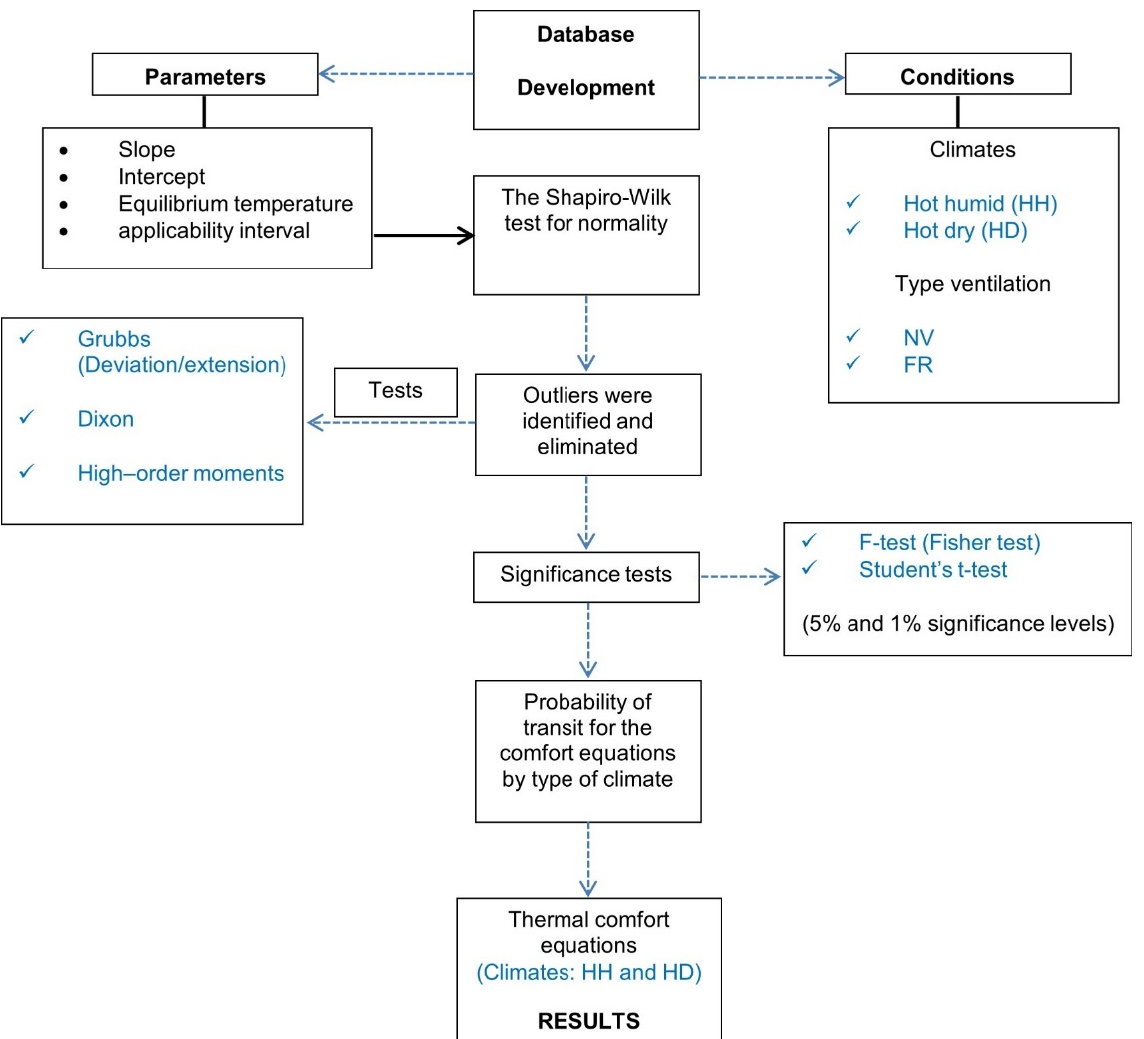
Figure 2. Methodological scheme to determine general thermal comfort equations. (NV: natural ventilation. FR: free running. HH: hot-humid. HD: hot-dry). ventilation. FR: free running. HH: hot-humid. HD: